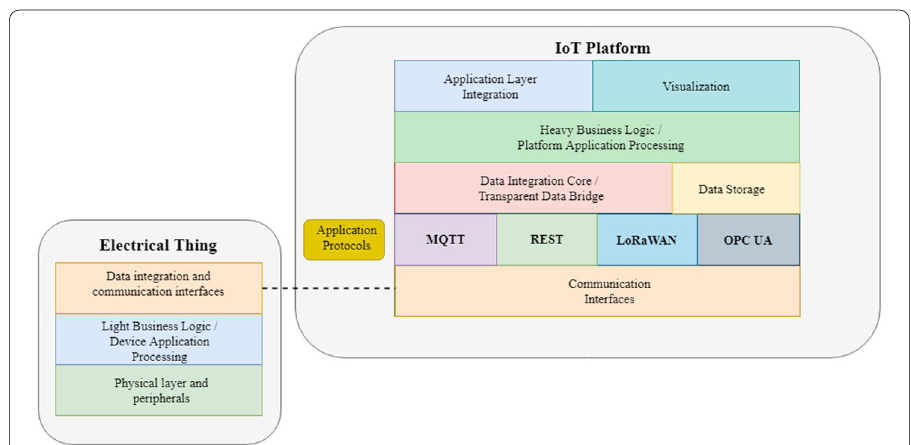
Fig. 2 The application architecture to integrate IoT